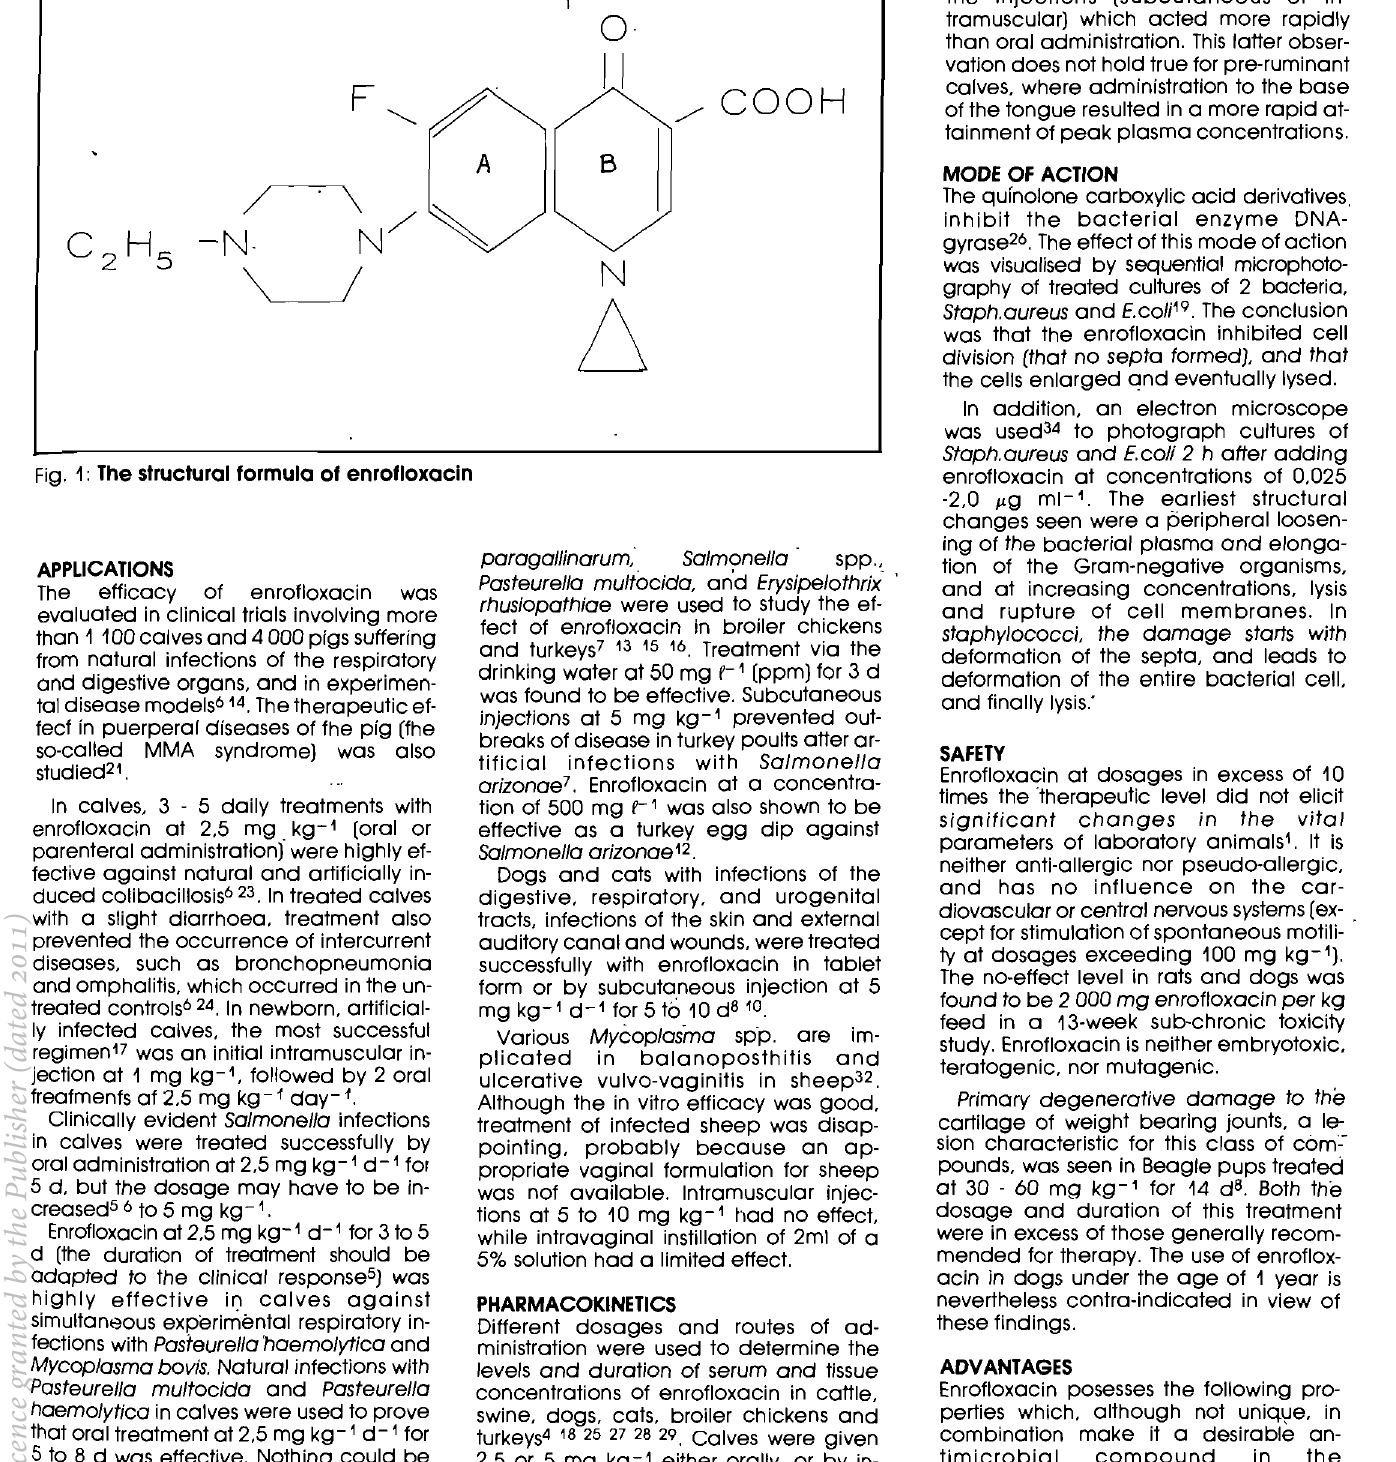
Fig. 1: The structural formula of enrofloxacin